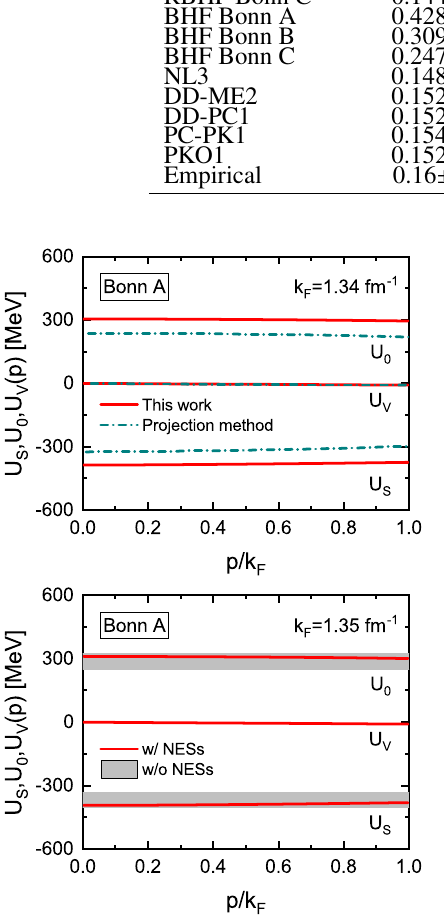
Figure 3. Momentum dependence of the single particle poten- tial. Treatment with NESs (red) is compared with two approx- imations: the projection method of Ref. [37] (upper part) and the momentum-independence approximation of Ref. [35] (lower part). The uncertainties of this approximation are shown by the gray shaded area. Figures taken from Ref.